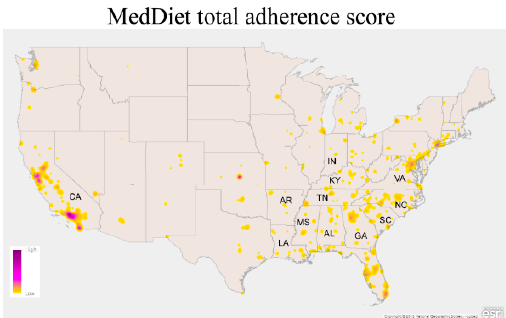
Figure 2. Heat map of MedDiet total adherence score data (low = 0; high = 13) created with ArcGIS ® software by Esri; color ramp increases in color depth (yellow to purple) as scores increase in value as indicated on the map legend. Source data: Esri, HERE, Garmin, NGA (National Geospatial-Intelligence Agency), USGS (U.S. Geological Survey), and the National Geographic Society. California and states in the Stroke Belt are indicated by their two-letter abbreviations.